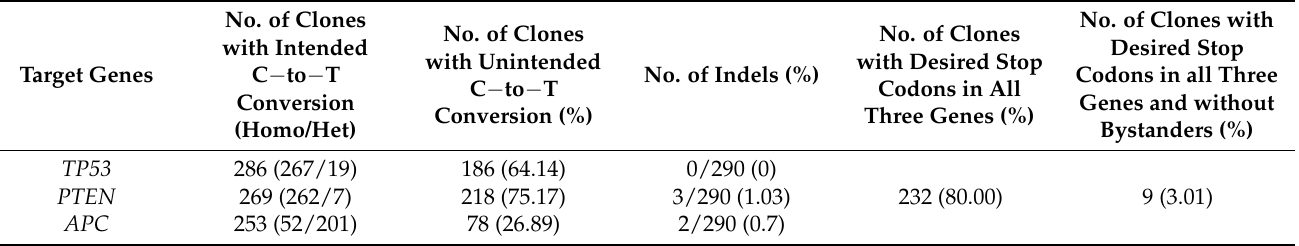
Table 1. Profile of the 290 PFF clones obtained from base editing using pCMV-hA3A-BE3-Y130F and 3